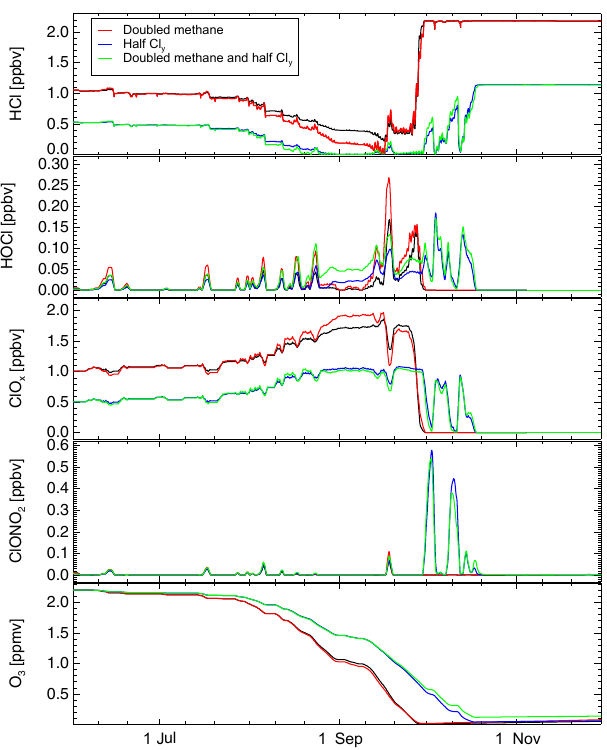
Figure 3. Sensitivity of the ozone hole chemistry on stratospheric methane and chlorine levels. The black line shows the reference case, the red line a case assuming initial methane to be doubled, the blue line a case assuming initial inorganic chlorine (Cl y ) to be halved, and the green line a case for initial methane doubled and Cl y halved.